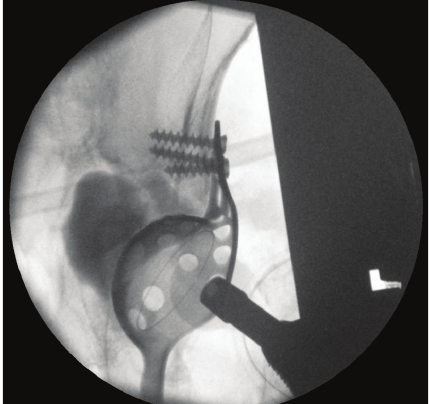
Figure 2: Fluoroscopy during surgery: acetabular fracture re- duced, Burch-Schneider antiprotrusio cage implanted, and CERA- MENT | BVF injected behind the cage.